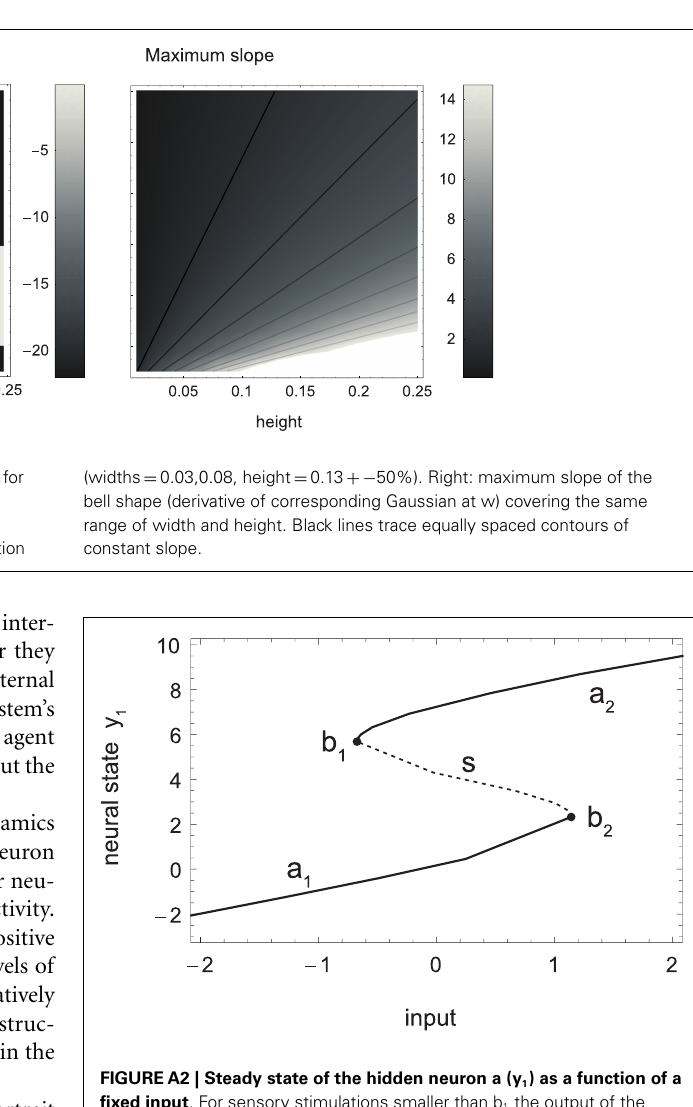
FIGUREA2 | Steady state of the hidden neuron a (y 1 ) as a function of a fixed input . For sensory stimulations smaller than b 1 the output of the neuron evolves toward a single point attractor (a 1 ), the position of which changes with the input value and is represented by a solid line). At the exact value of b 1 a saddle-node bifurcation creates a new fixed point (a 2 ) and a saddle node (s, dashed line). As input increases further, both fixed-points move toward higher levels of hidden neuron activation. Eventually, in a second (reverse) saddle-node bifurcation at b 2 , fixed-point a 1 collides with the saddle node and both vanish, leaving only attractor a 2